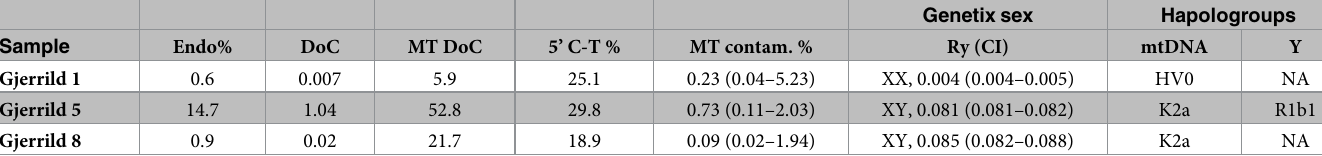
Endo% is the endogenous DNA content, being the proportion of sequences identified as human. DoC and MT DoC is the genomic depth of coverage of the genome and mitochondrial genome, respectively. 5’C-T % is the proportion of C to T misincorporation damage at the first position of the 5’ end. Genetic sex was estimated with the Ry value [46] shown here with 95% CI. MT Contam % is the contamination proportion (and 95% confidence interval) based on mtDNA. mtDNA and Y-chromosome haplogroups are also